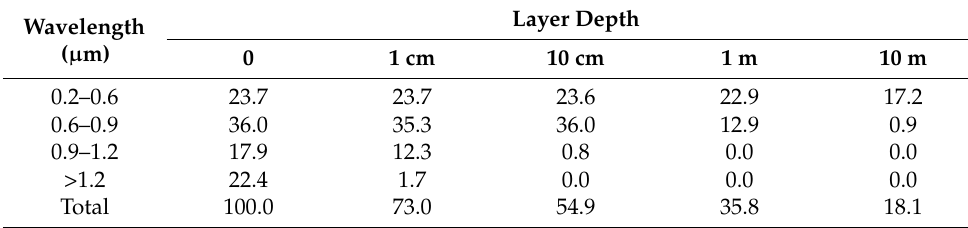
Figure 15. Vertical cross-section of a solar pond. Table 10. Spectral absorption of solar radiation in water